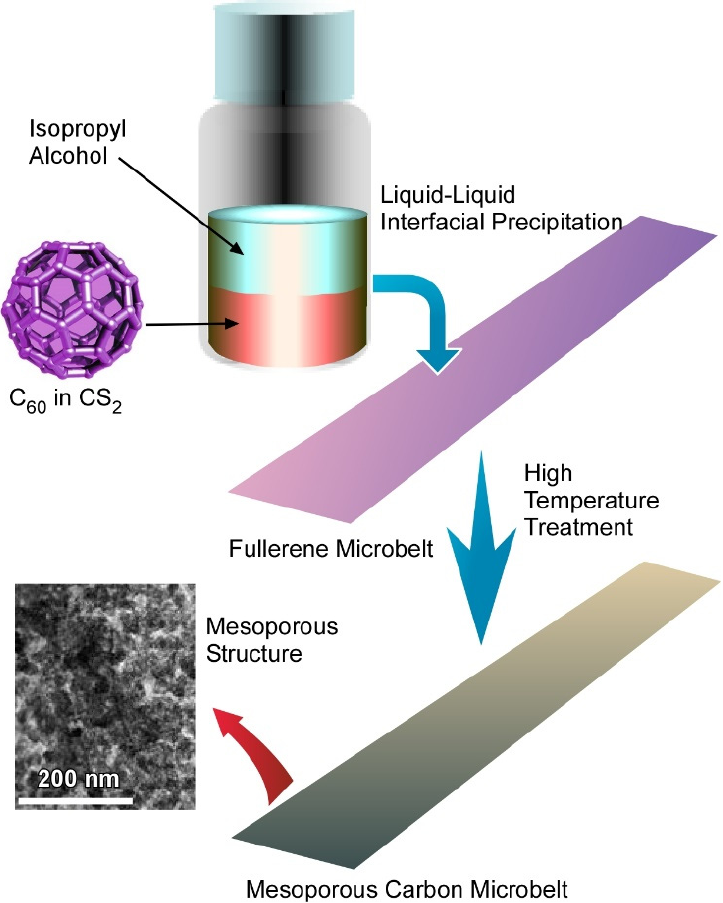
Figure 8. Fabrication of two-dimensional fullerene microbelts through transformation of fullerene assembly to mesoporous carbon with retention of their original sheet-like structure. Reprinted with permission from Reference [155]. Copyright 2017 American Chemical Society.